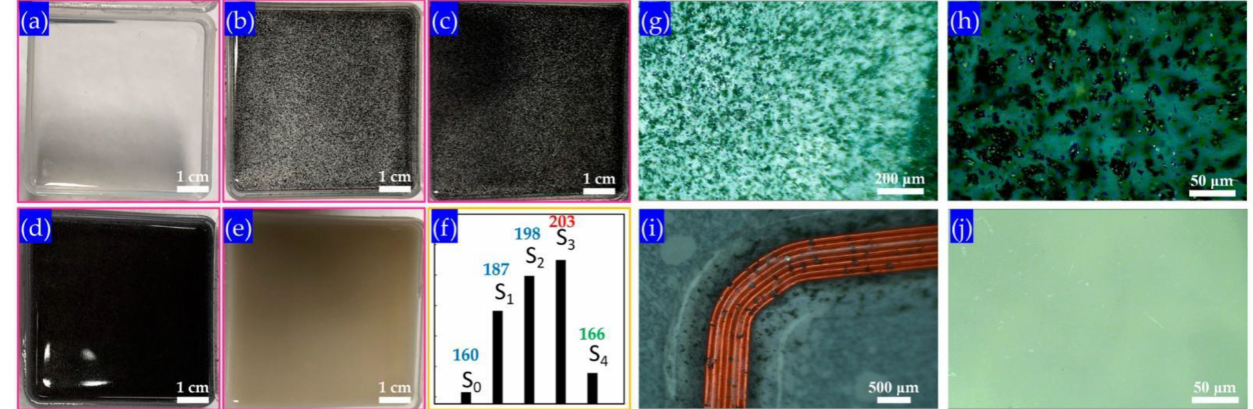
Figure 1. ( a ) S0 sample as-received PDMS membrane after curing; and ( b ) S1 sample with 8.7 wt.% graphene addictive; ( c ) S2 sample with 12 wt.% graphene additives; ( d ) S3 sample with 17 wt.% graphene additives; ( e ) S4 sample with 17 wt.% ND additives; and ( f ) measured thermal conductivity (unit in figure: mW/(m.k)), labeled as S0 to S4, in corresponding from ( a – e ), respectively. The detailed optical microscope images were acquired with different magnifications from ( g – i ) optical image on 17 wt.% graphene addictive and ( j ) ND addictive PDMS. All the optical images ( g – j ) were observed through Nikon